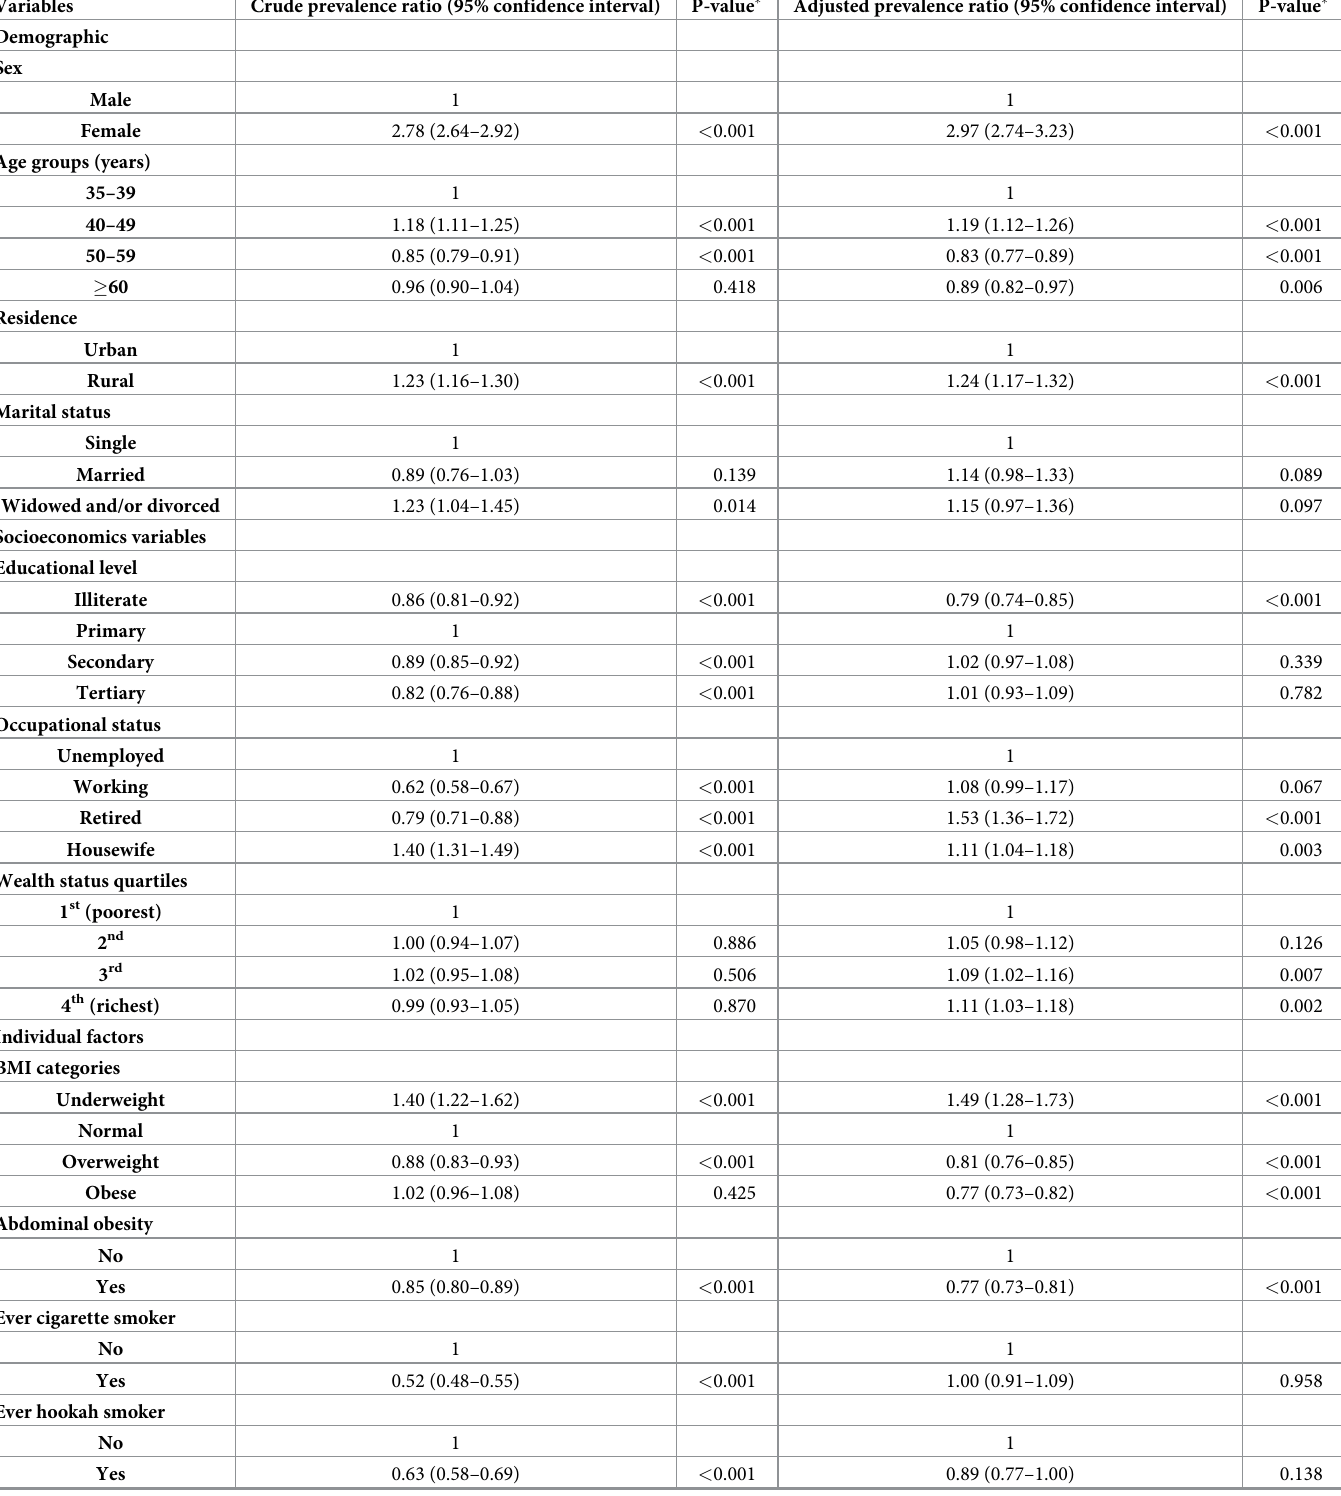
Table 3. Univariate and multivariable Poisson regression analysis with robust variance of factors associated with